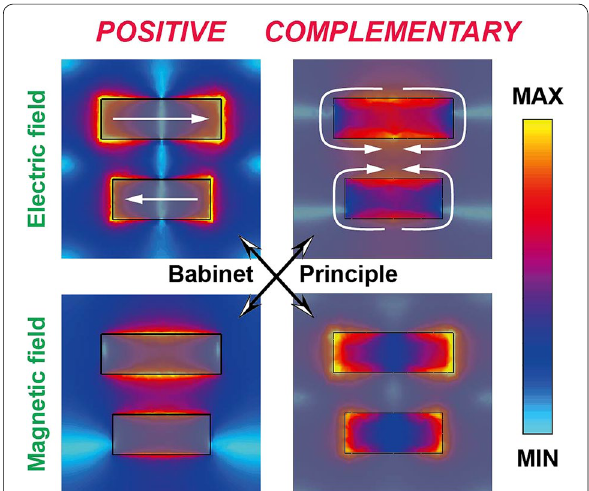
Fig. 3 Simulated electric and magnetic field distributions of the positive and complementary asymmetric dipole bars at asym- metry parameter of 0.190 which validate the Babinet’s Principle for electromagnetic fields. The maximum electric and magnetic field strengths of the positive and complementary asymmetric dipole bars are (2.6